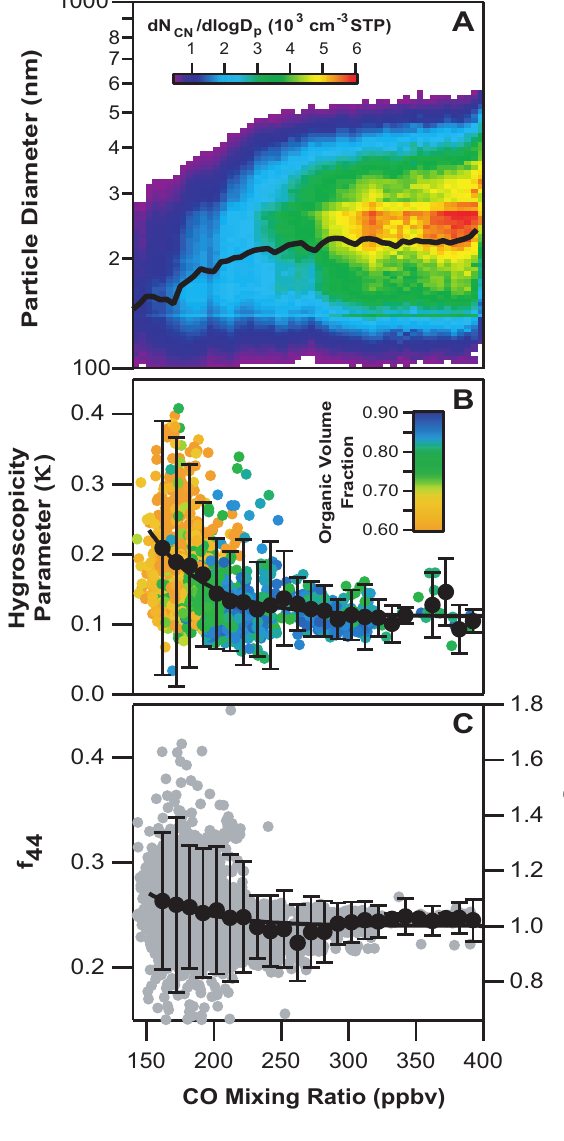
Fig. 7. (a) Average particle size distribution for all biomass burning plumes sampled, colored by number concentration, and plotted versus CO mixing ratio. The black trace denotes the distribution geometric mean diameter. (b) CCN-derived biomass burning aerosol hygroscopicity, colored by aerosol organic volume fraction from the C-ToF-AMS, and plotted versus CO mixing ratio. (c) f 44 ratio obtained from the C-ToF-AMS (averaged to 5-minute intervals) plotted versus CO mixing ratio. The black-circles in (b) and (c) denote the mean κ and error bars represents one standard deviation from the mean.